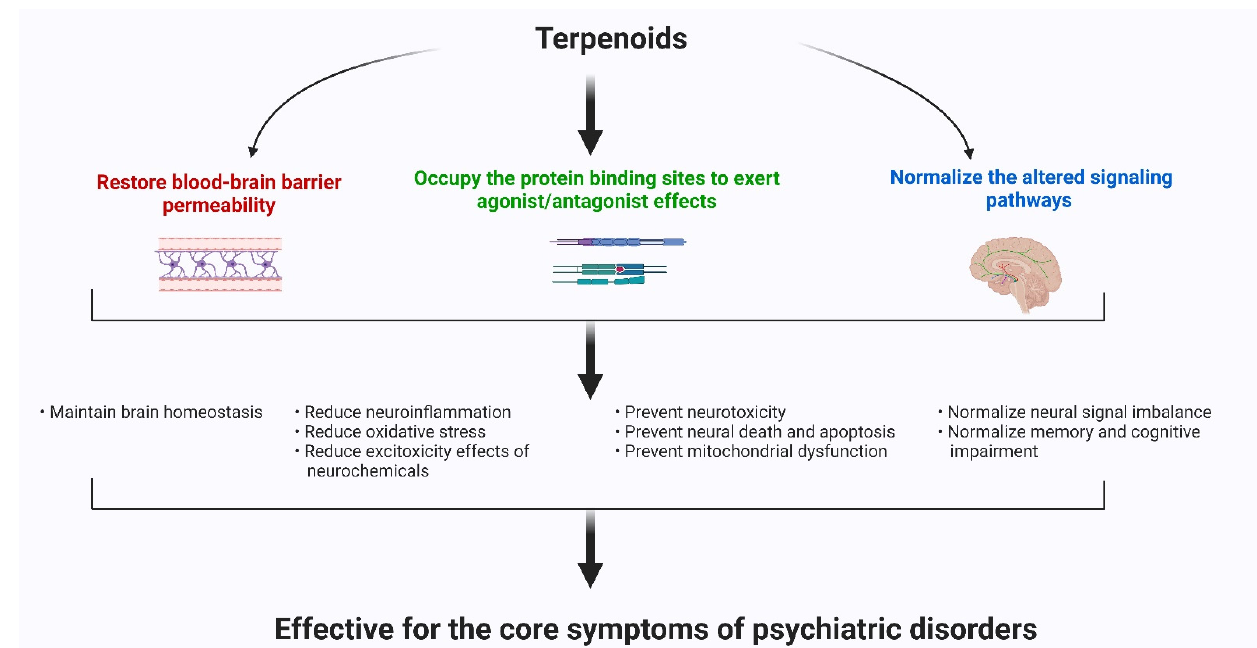
Figure 2. The major mechanisms of action of terpenoids.